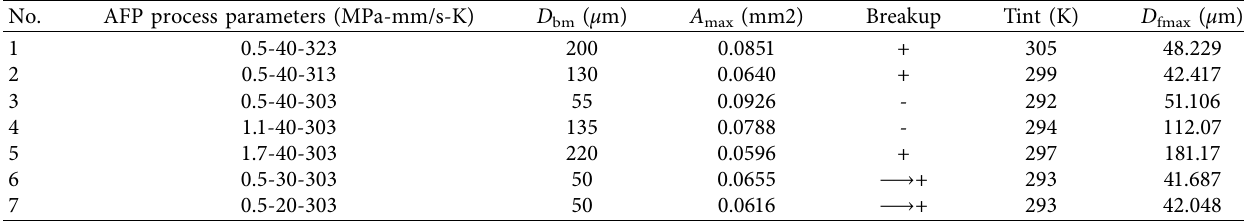
Note: “+” represents that the bubble has broken up. “-” represents the normal bubble. “ ⟶ +” represents that the bubble is breaking